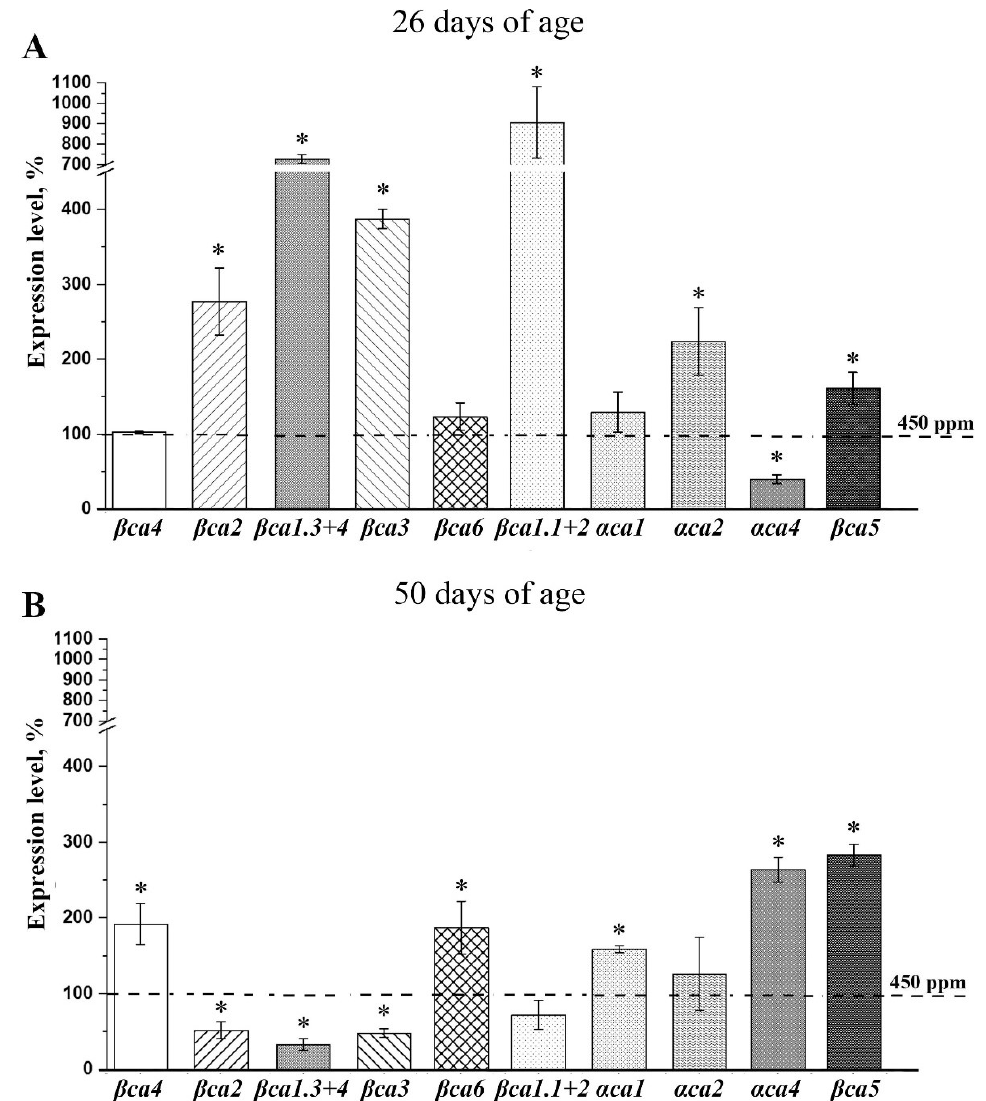
Figure 7. Levels of expression of genes encoding CAs in leaves of Arabidopsis plants of 26 ( A ) and 50 ( B ) days of age after 16 days introduction to low (150 ppm) CO 2 level in the air. The 100% value (dashed horizontal line) is the expression level of the corresponding genes encoding CAs in the Control plants, according to Table 2, for 26 ( A ) and for 50 ( B ) days of age grown at 450 ppm. Data are shown as mean ± the SE. Asterisks denote statistically significant differences between values for different CO 2 levels on the same experimental day, p < 0.01.